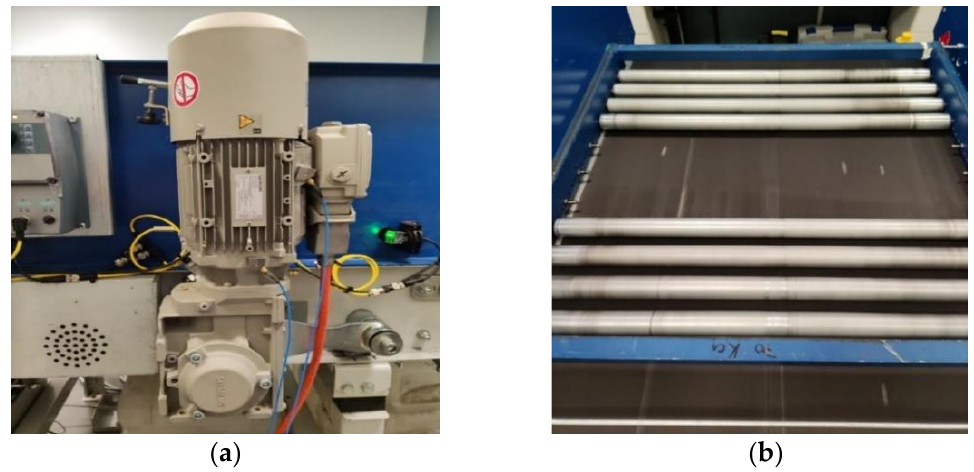
Figure 2. ( a ) The gearmotor of the belt conveyor system. ( b ) The loaded (20 kg) belt conveyor system.